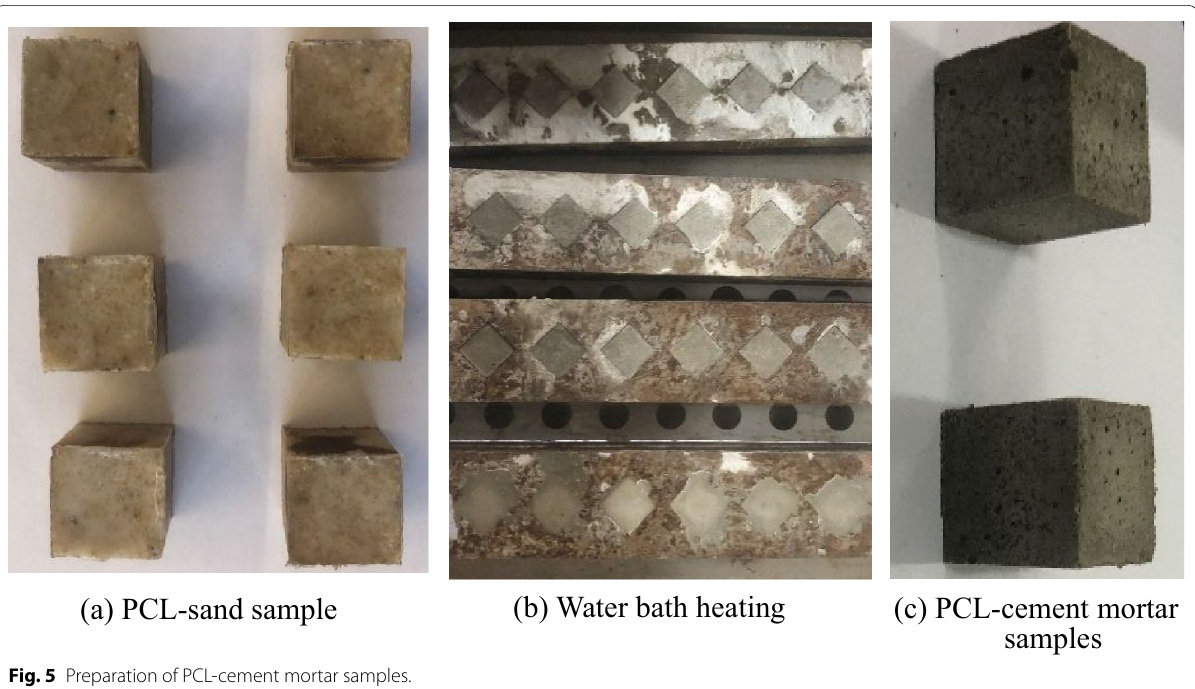
Fig. 5 Preparation of PCL‑cement mortar samples.